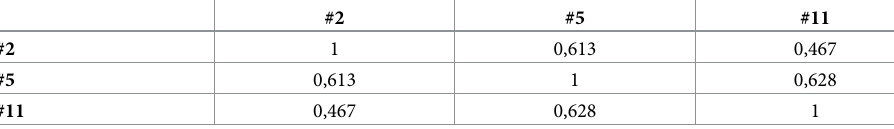
Table 13. Inter-item correlation matrix for subscale 2 (IGs).